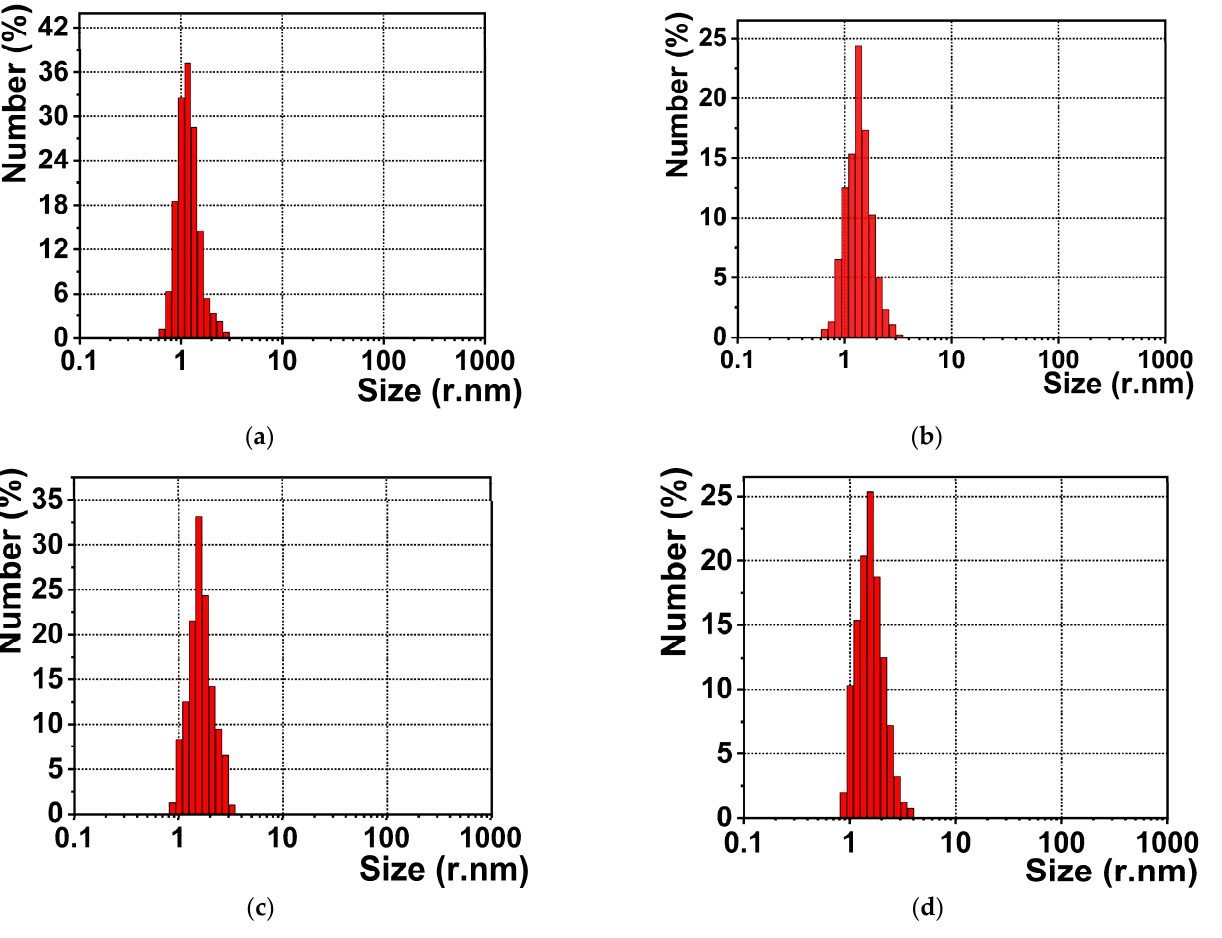
Figure 6. DLS data of Pep-CuNCs in the presence of ( a ) 0.5, ( b ) 1.0, ( c ) 2.0, and ( d ) 3.0 µM Pb(II) ions concentrations.